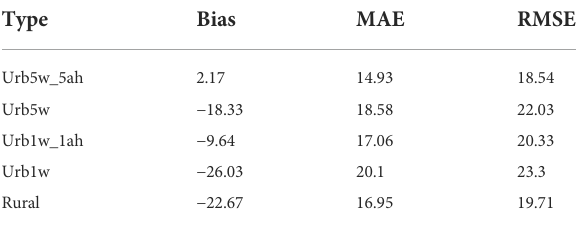
TABLE 3 Assessment of model-simulated